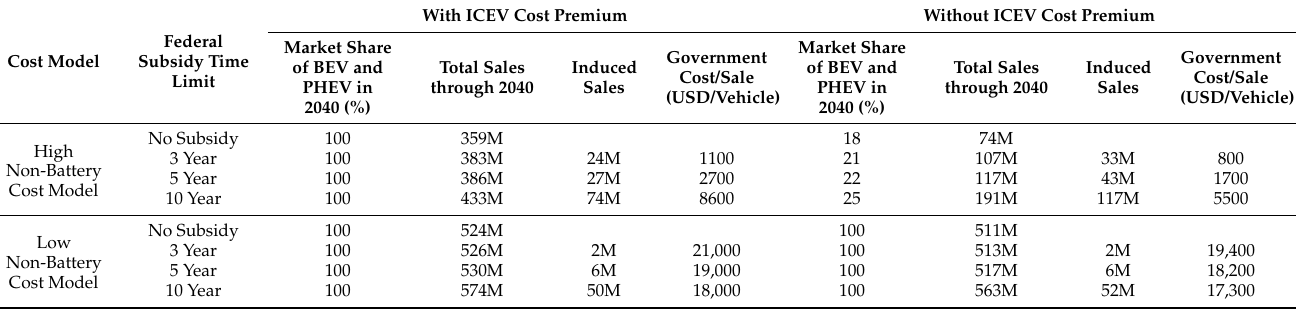
Table 2. Impact of federal subsidies (which vary by battery size up to USD 7500, reflecting current U.S. policy) in inducing the sales of ETVs. The first column shows the cost model used to estimate the non-battery EV technology costs. The second column indicates the duration of the federal subsidy. The other columns show the total sales of BEVs and PHEVs, additional ‘induced’ sales because of federal subsidies, and cost to the government per induced sale, when ICEV Cost Premium is present or not. (‘M’ indicates